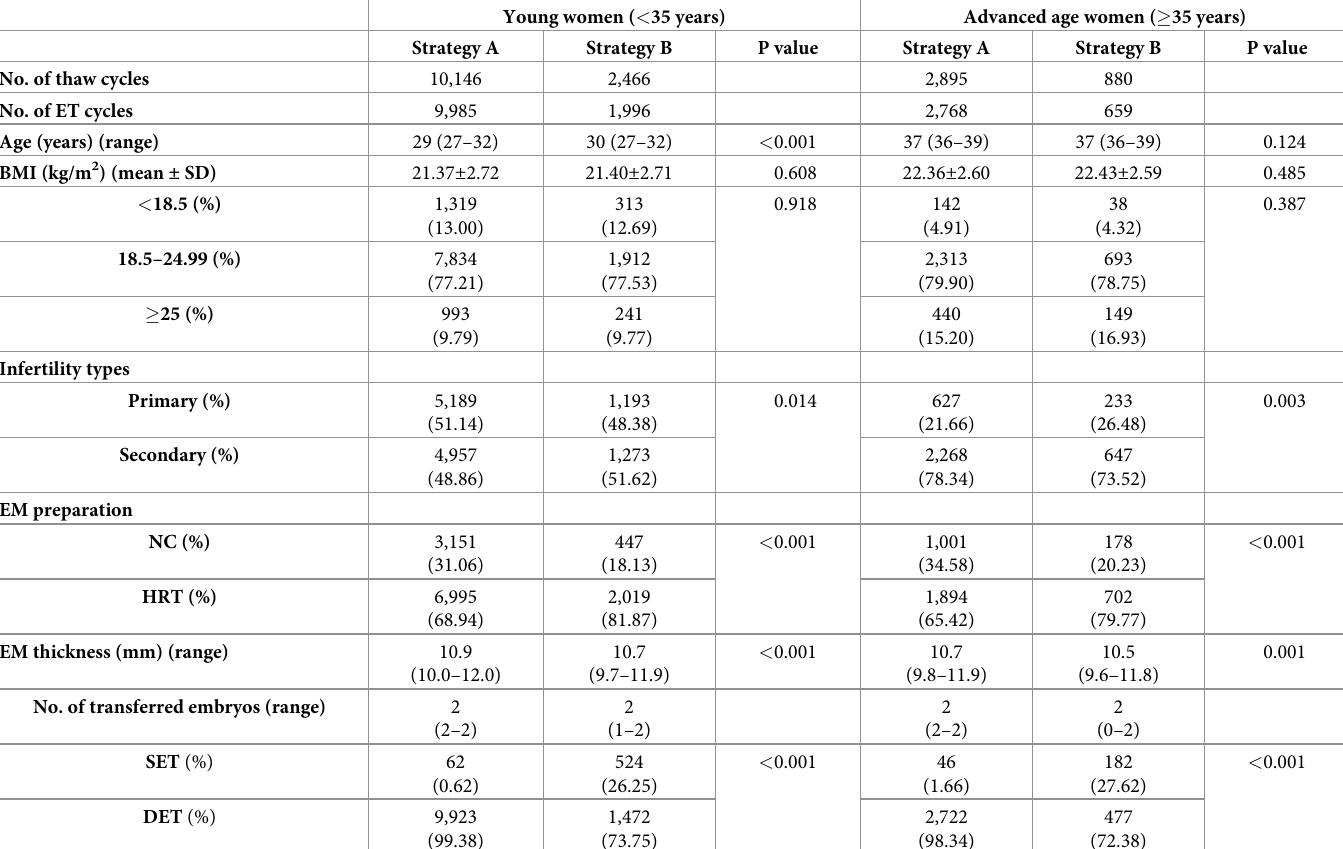
Table 1. Patient